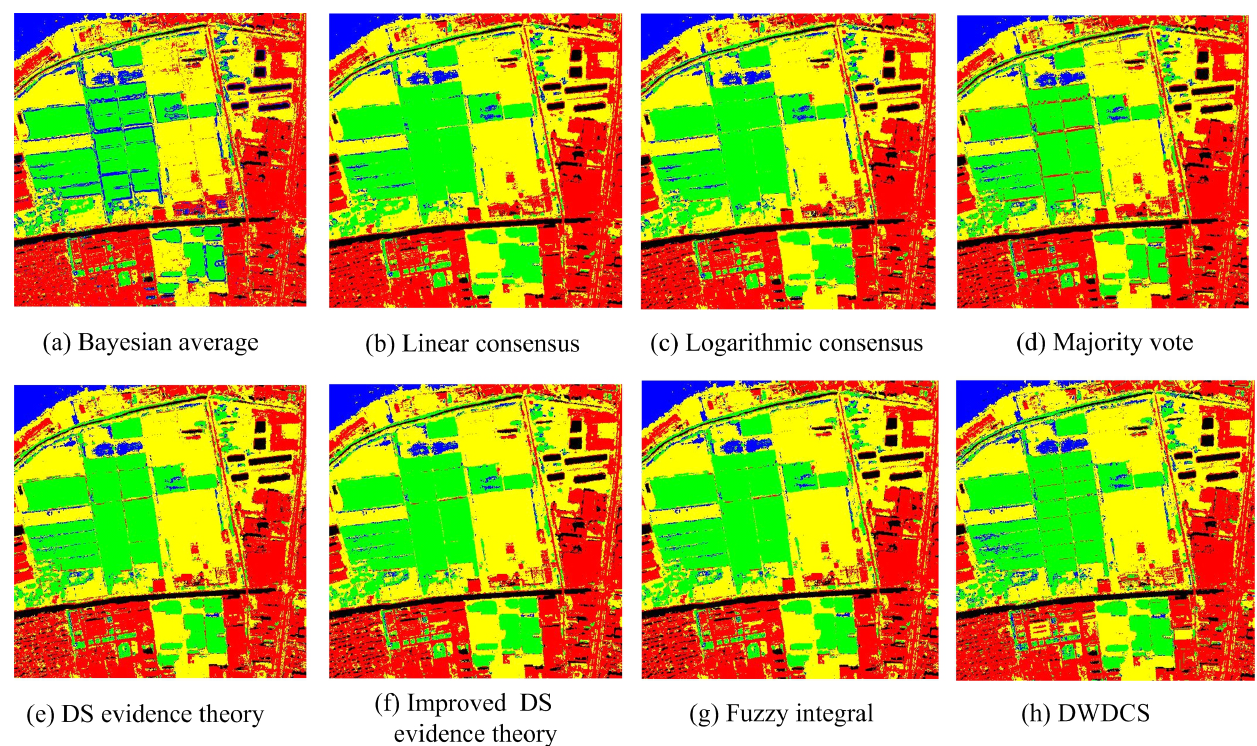
Figure 9. Classification results based on parallel combination approaches.